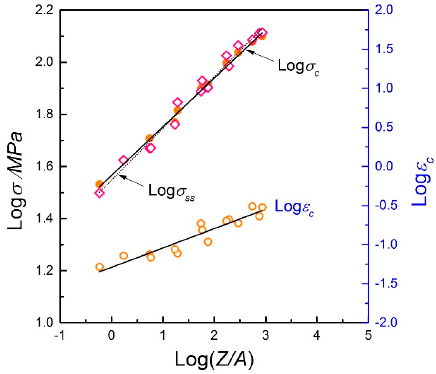
Figure 9. Relationships between the dimensionless parameter, Z / A , with σ c , σ ss , and ε c , respectively.